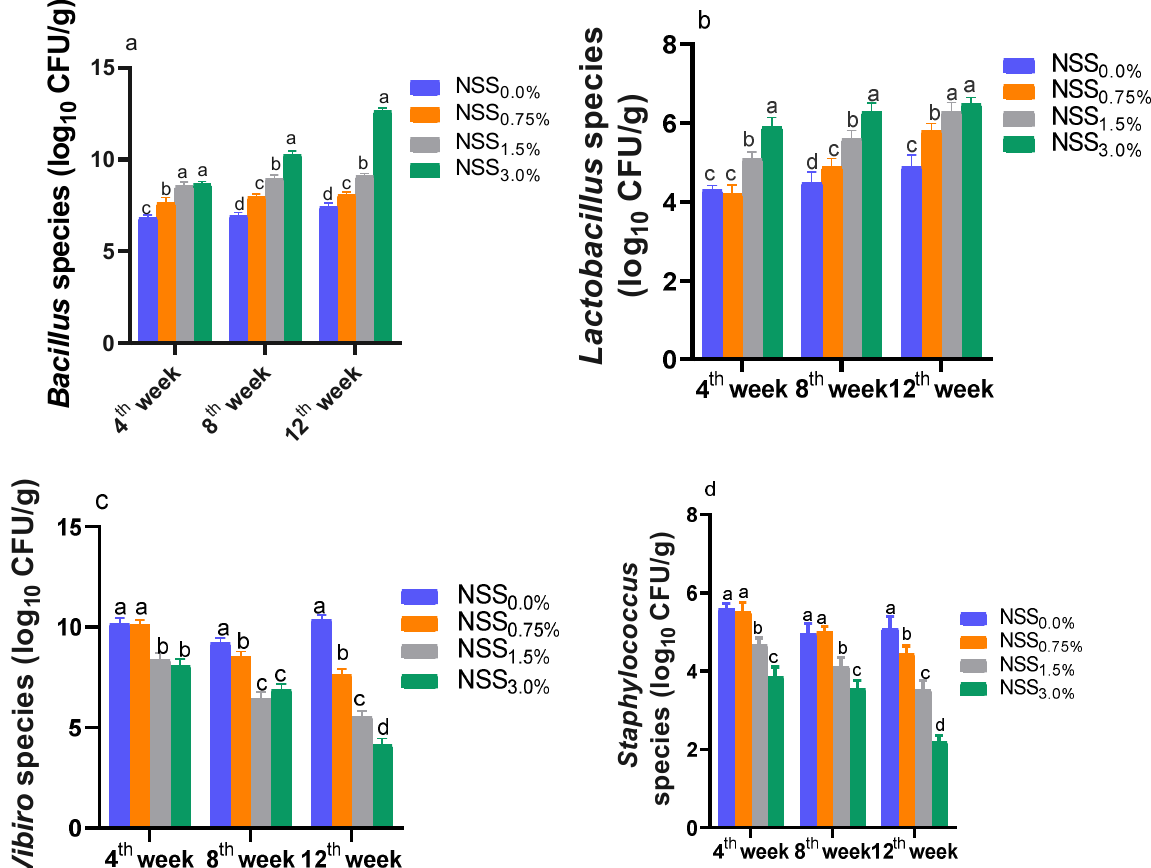
Figure 3. Effect of supplementing diets with varying levels of a microalgae mix (NSS) containing Nannochloropsis oculate and Schizochytrium and Spirulina species at equal proportions (1:1:1) for 12 weeks on the population of some beneficial ( Bacillus , ( a ) and Lactobacillus , ( b )) and pathogenic ( Vibrio , ( c ) and Staphylococcus , ( d )) species in Nile tilapia intestinal samples at 4, 8, and 12 weeks of age. Data are expressed as means ± SE. Bars with different letters denote significant differences ( p < 0.05). NSS: microalgae mix containing Nannochloropsis oculate and Schizochytrium and Spirulina species at equal proportions (1:1:1), NSS 0.0% : control group fed basal diet free from NSS, NSS 0.75% : basal diet supplemented with 0.75% of NSS, NSS 1.5% : basal diet supplemented with 1.5% of NSS, NSS 3.0% : basal diet supplemented with 3% of NSS.